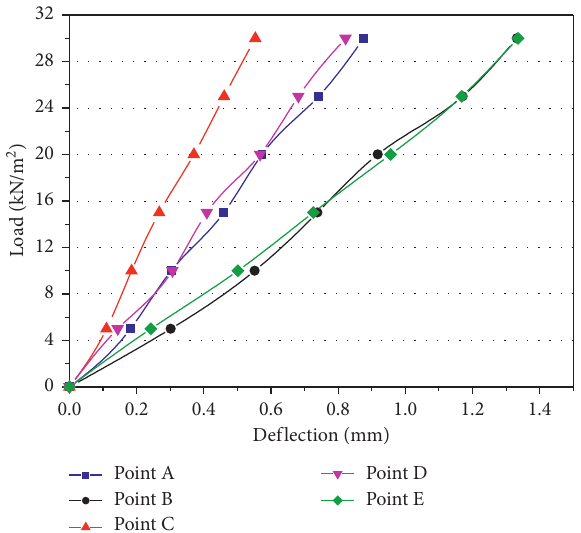
Figure 13: Load-deflection curves of the three-span continuous formwork specimens.